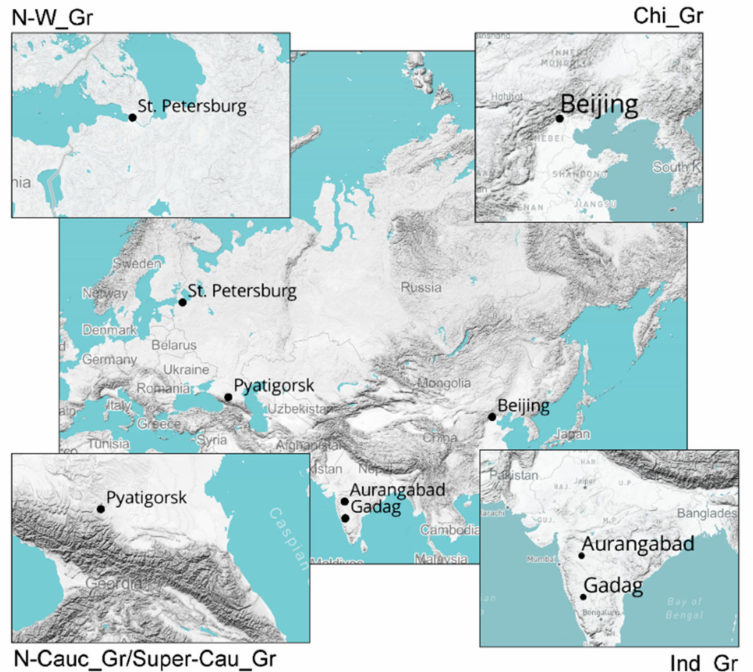
Figure 1. Regions under study: N–W_Gr—St. Petersburg (Russia); N-Cauc_Gr/Super-Cau_Gr— north Caucasus (Russia); Ind_Gr—the states of Karnataka and Maharashtra (India); and Chi_Gr— Beijing